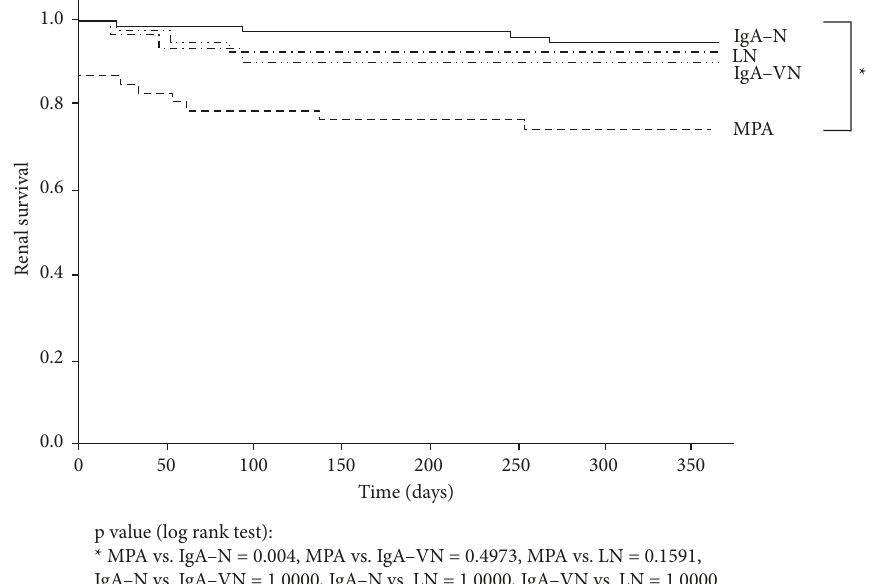
Figure 2: One-year renal survival according to the four classifications of glomerulonephritis with crescents. One-year renal survival was analyzed using the Kaplan–Meier method, and a significant difference was only observed between MPA and IgA-N ( p 0 . 004). The solid (cid:31) line indicates IgA-N. The dotted lines indicate type III MPA. MPA, microscopic polyangiitis; IgA-N, immunoglobulin A nephropathy; LN, lupus nephritis; IgA-VN, IgA vasculitis with nephritis. Table 4: Univariate and multivariate analysis of factors affecting renal prognosis microscopic polyangiitis and immunoglobulin A nephropathy. Univariate analysis Multivariate